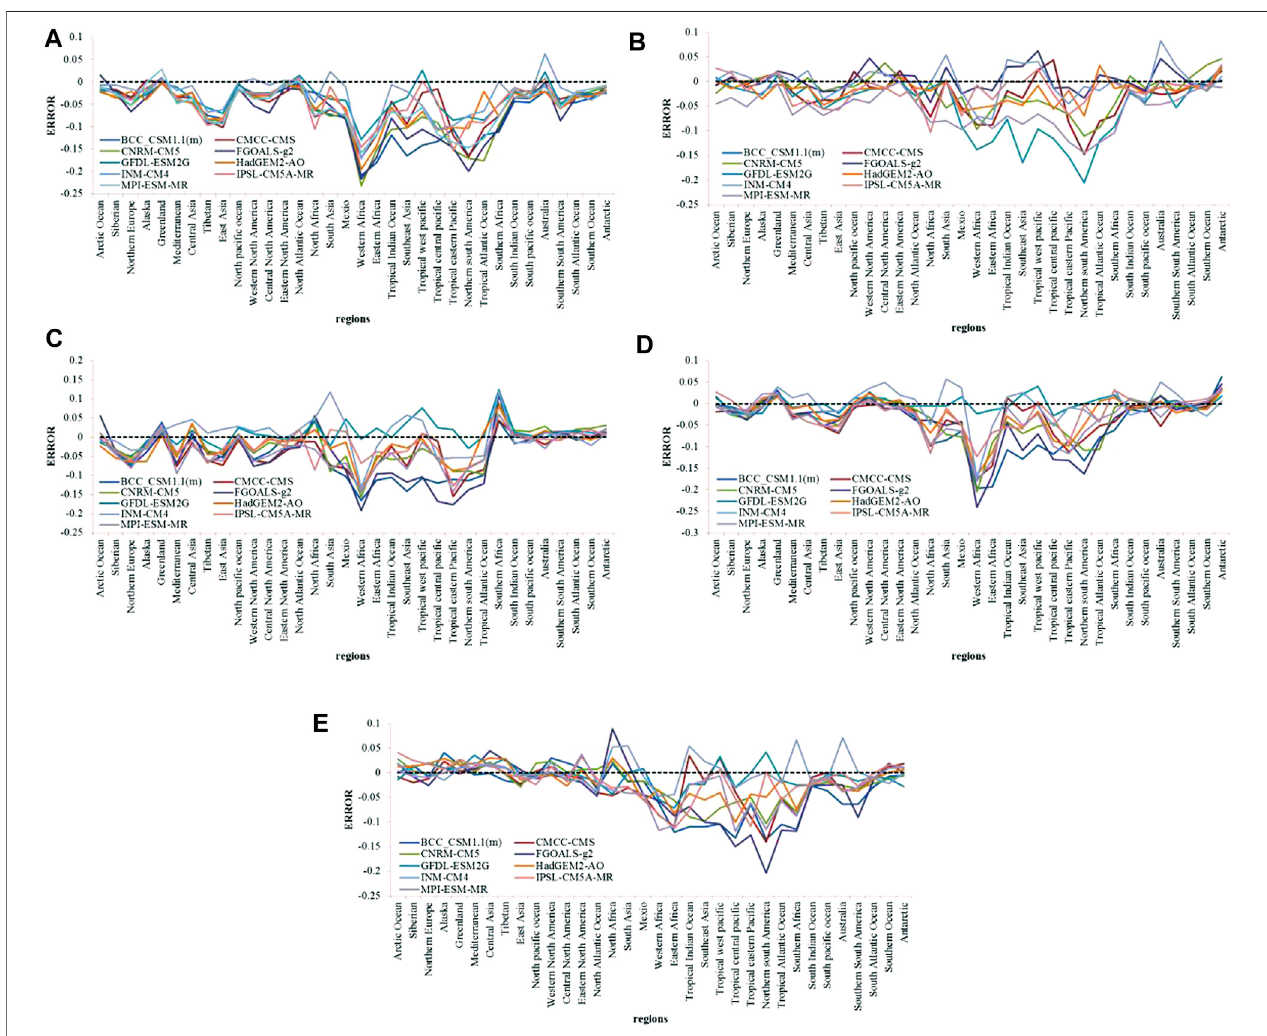
FIGURE 6 | The biases of the region average scaling exponents between CMIP5 models and NCEP for (A) year; (B) spring; (C) summer; (D) autumn; (E) winter.